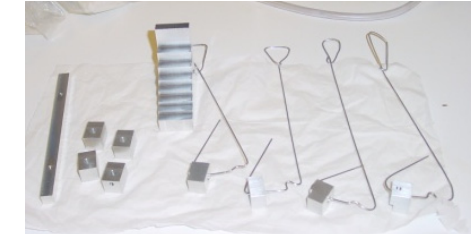
Figure 8. Test cubes after trial run for Figure 7. Surface treatment by alkaline etching lined up for test 3D alkaline etching in the lab: scan additionally to mechanical suspending the test cubes in clocking. the sodium hydroxide solution.